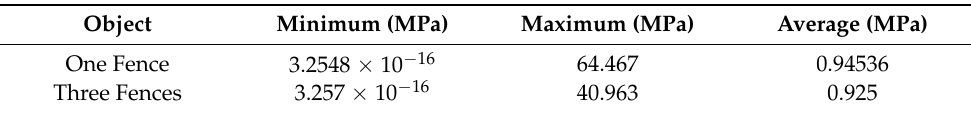
Table 7. Stress Values when Increasing the Vertical Load on the Posterior Jaw to 150 N while Decreasing the Load on the Anterior Jaw to 50